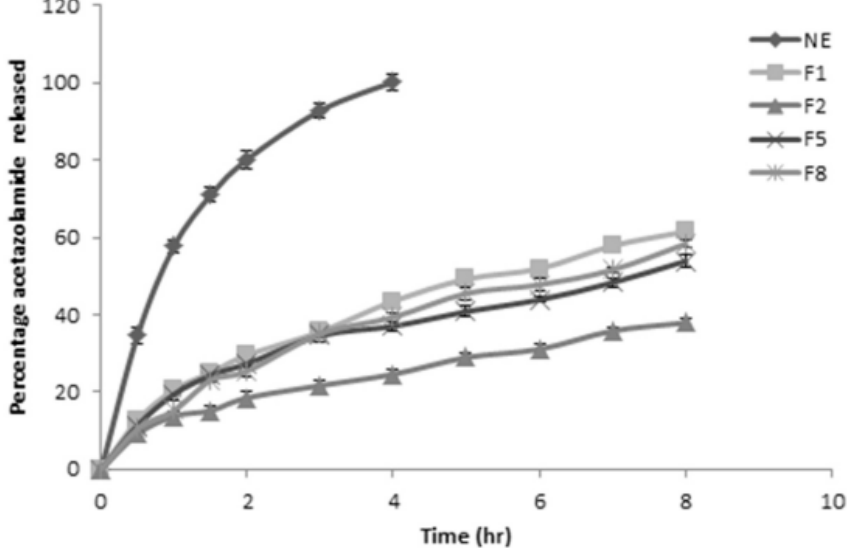
Figure 12. Percent of drug released from nanoemulsion (NE), nanoemulsion in situ gel gellan (F1), nanoemulsion in situ gel gellan/xanthan (F2), nanoemulsion in situ gel gellan/HPMC (F5), and nanoemulsion in situ gel gellan/carbopol (F8) Reprinted with permission from [118]. Copyright 2022, Elsevier.